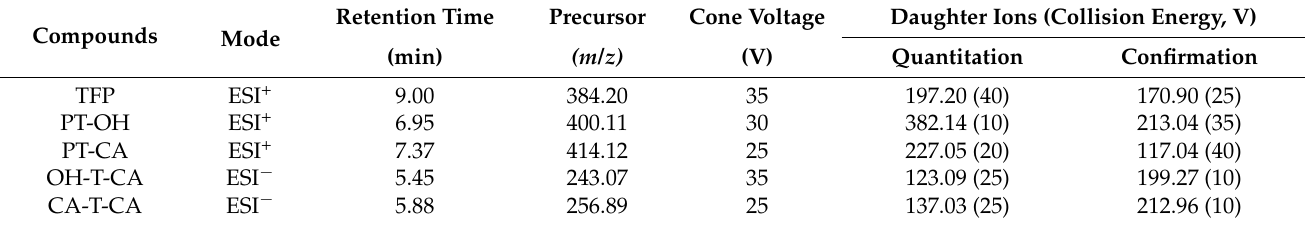
Table 2. The optimum MRM parameters for TFP and its